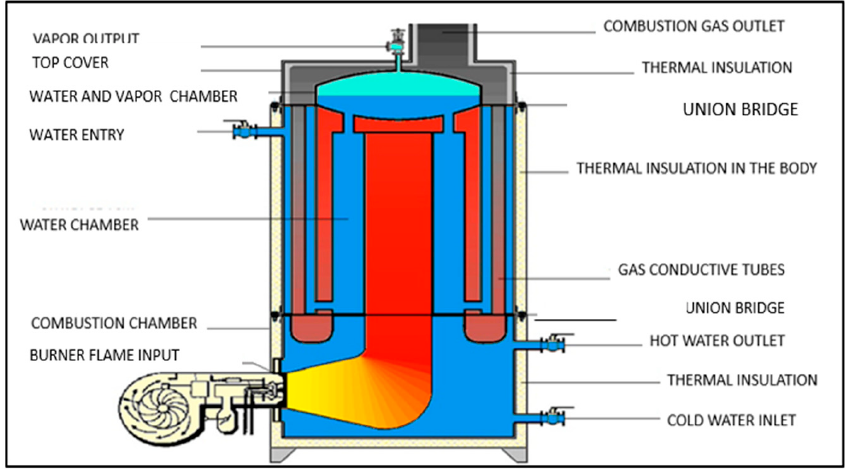
Figure 15. The dome shows the water steam (light blue color) and the exit of the hot water in the combustion chamber; in gray and black color, the combustion gases coming out of the chimney are shown.